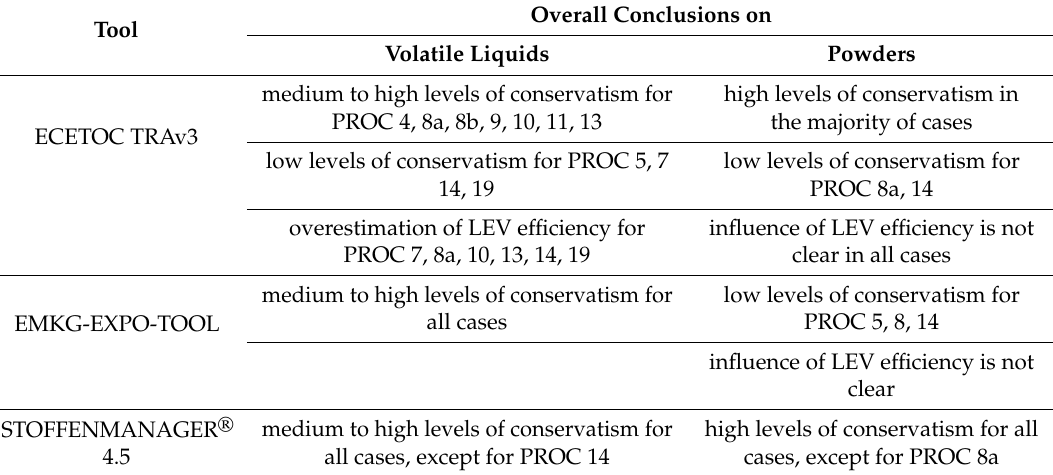
Table 2. Critical PROCS and influence of LEV in ECETOC TRAv3, EMKG-EXPO-TOOL, STOFFENMANAGER ® . Overall Conclusions on Tool Volatile Liquids